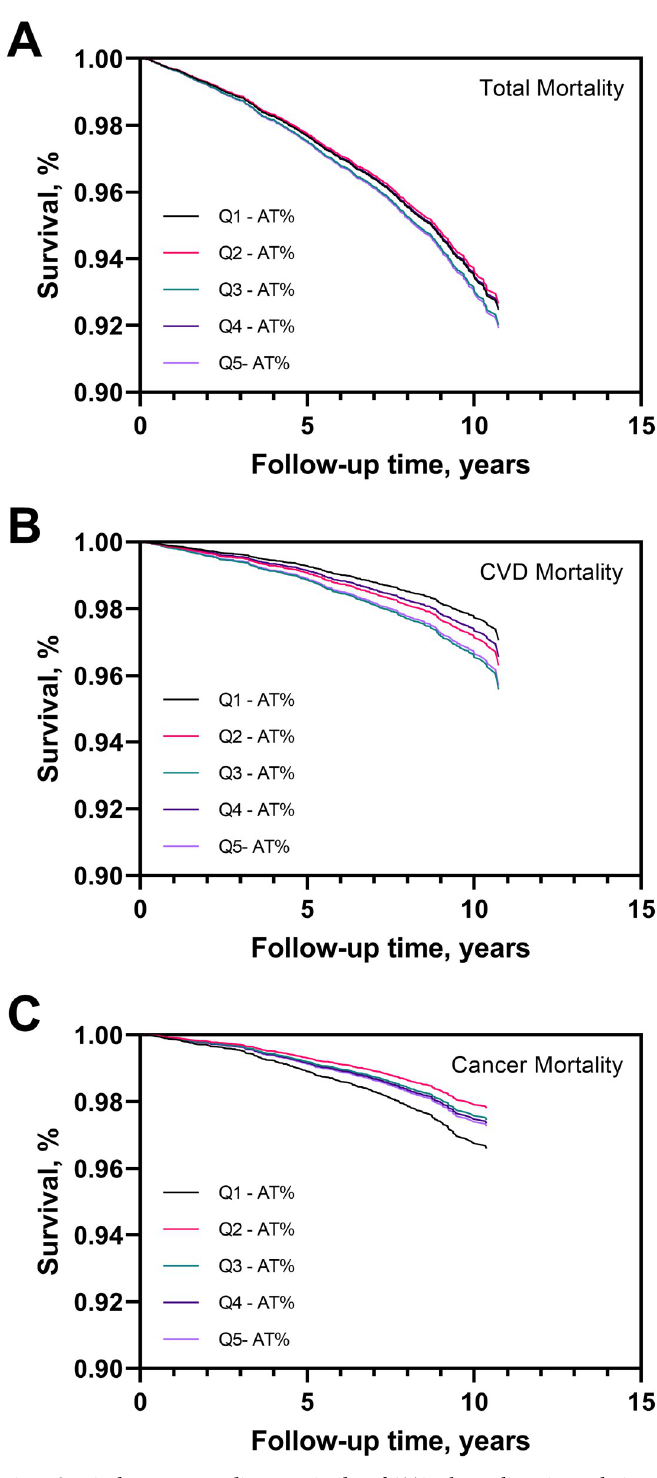
Fig 2. Survival curves according to quintiles of AT in the Moli-sani population (n = 19,676). Survival curve for total mortality (A), cardiovascular disease related mortality (B) and cancer mortality (C) for the quintiles of AT. The curves were adjusted for age, sex, current smoking, BMI, diabetes status, hypertension status, hypercholesterolemia status, history of cardiovascular disease, history of cancer, vitamin K antagonists, antiplatelet medication, heparin use, oral